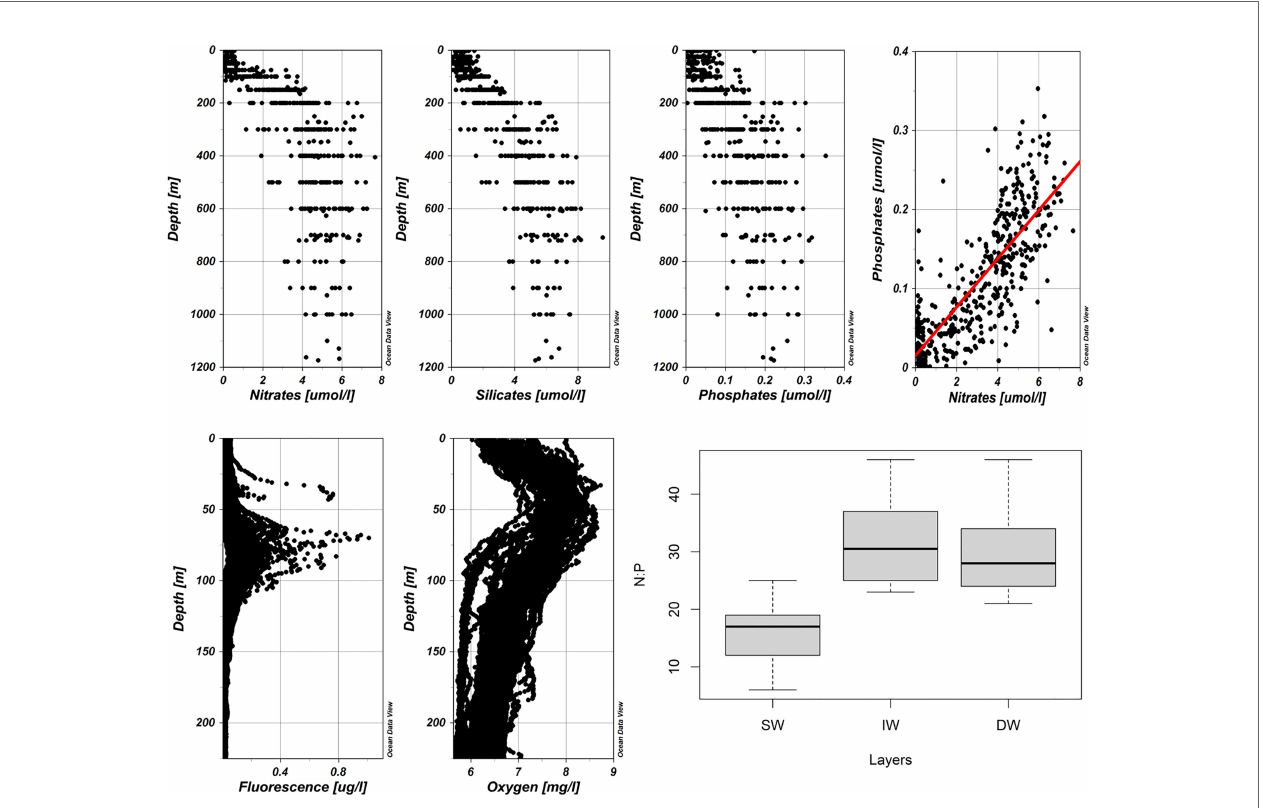
FIGURE 4 | In top panels are reported the vertical pro fi les of nitrates, silicates, phosphates, nitrates-phosphates diagram (in red, the regression line with the R 2 >0.8). In bottom panels are reported the vertical pro fi les of fl uorescence and dissolved oxygen of all stations, followed by the N:P ratio box plots in SW, IW and